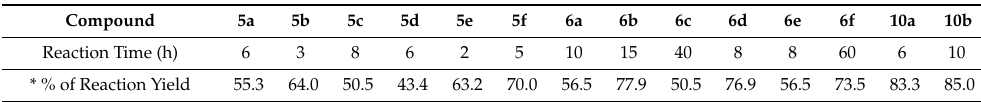
Table 3. The reaction time and % of reaction yield of the synthesis of monoalkoxy, monohydroxy 2,2-dimethylchroman-4-ones (5a – f) , dialkoxy, 2,2-dimethylchroman-4-ones ( 6a – f ), and monoalkoxy, 2,2-dimethylchroman-4-ones (10a – b)